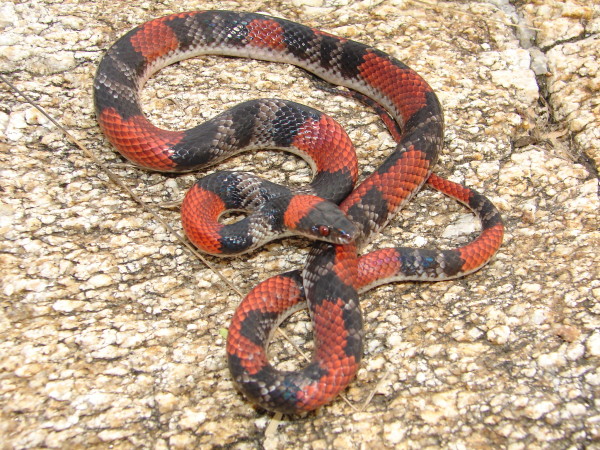
Oxyrhopus trigeminusDumeril, Bibron & Dumeril, 1854 (Photo - Washington Vieira).